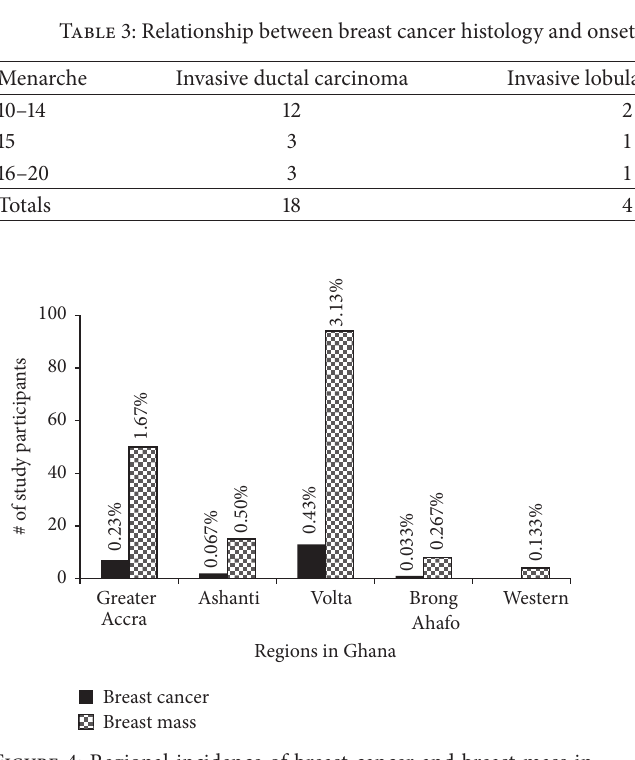
Figure 4: Regional incidence of breast cancer and breast mass in study participants. Incidence and distribution of breast cancer in the five regions under study are shown. Notably, Volta Region had the highest case burden followed by Greater Accra Region. Histological classifications per region are shown in Table 2. The percentages were calculated based on the total number of diagnosed cases per region over total participants recruited. 𝑃 < 0.005 .